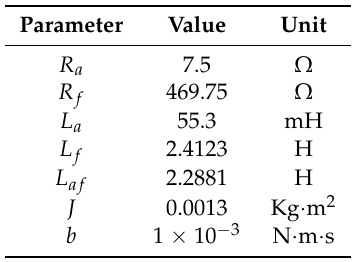
Table 2. Parameters of the DC shunt